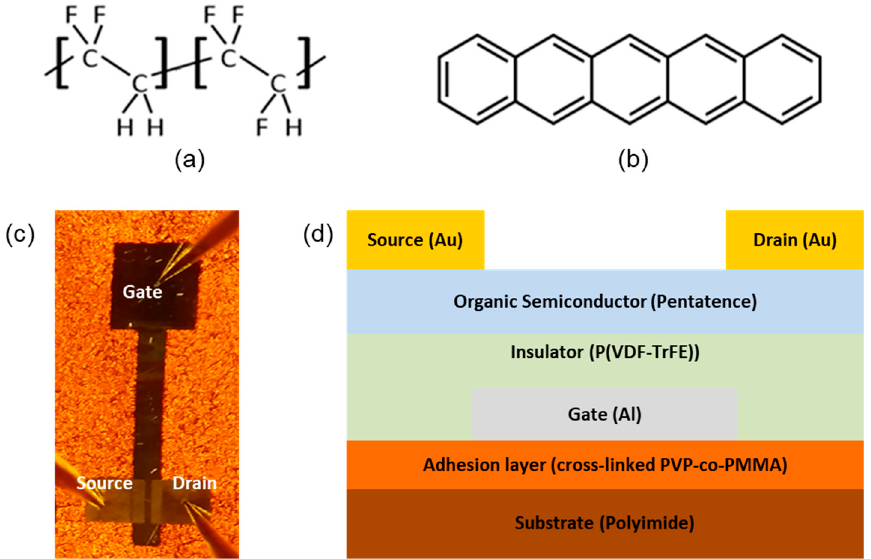
Figure 1. Molecular structures of ( a ) P(VDF-TrFE) and ( b ) pentacene; ( c ) optical microscopy image of a measured flexible Fe-FET; ( d ) cross-section schematic of flexible Fe-FET.